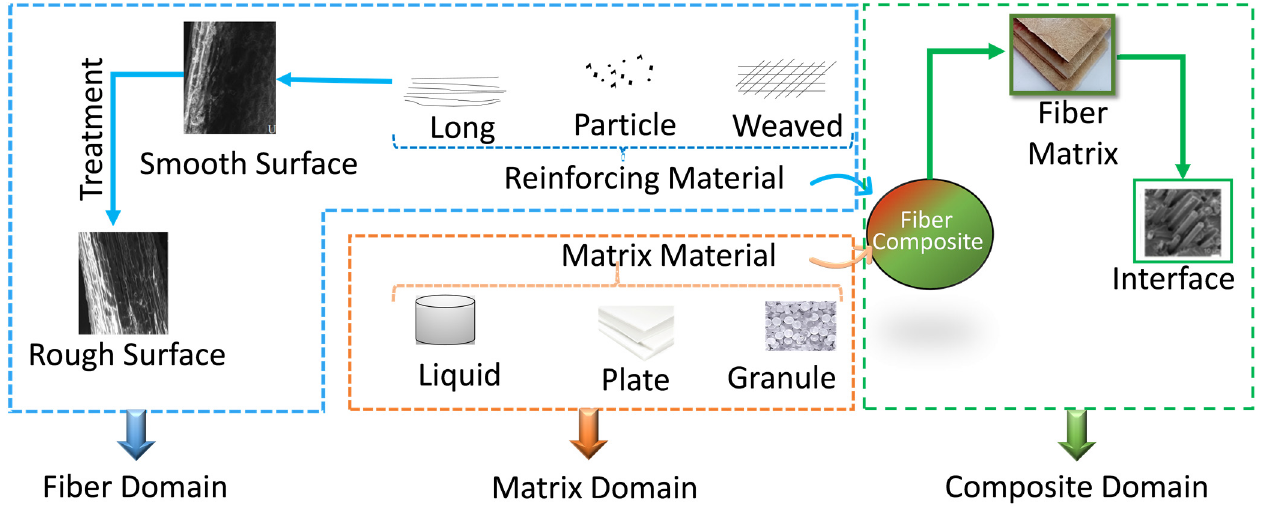
Figure 2. Different forms of matrix and jute fiber reinforcing materials.